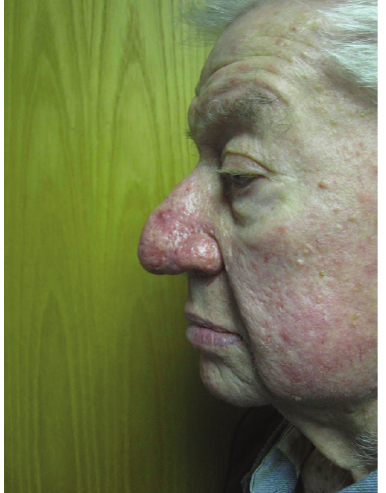
Figure 10: Case 3, three week postoperative lateral.